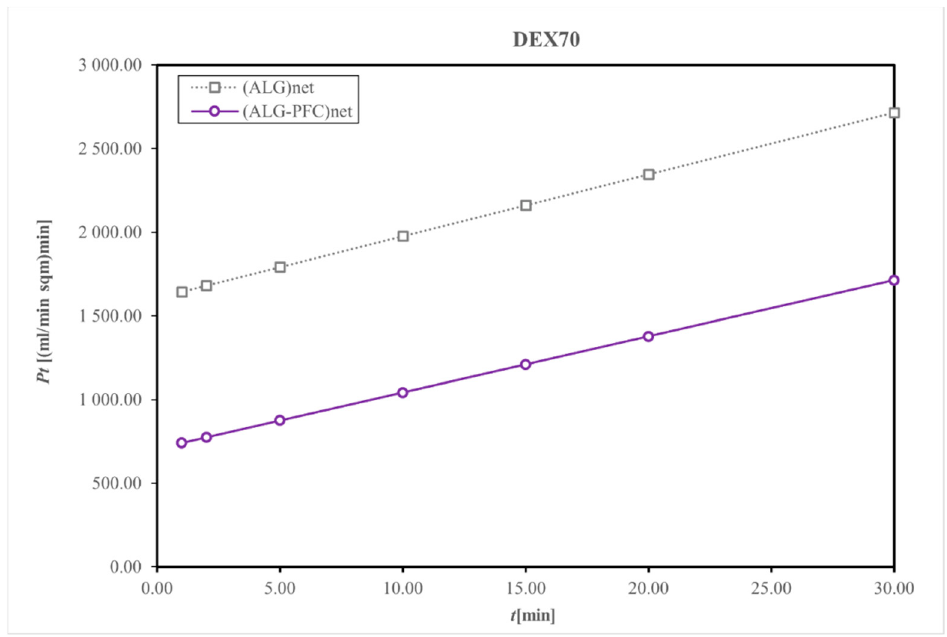
Figure 7. Representative membrane permeability and time product during particular time intervals permeation for Dextran 70. Key to symbols: (ALG-PFC) net —alginate–perfluorooctyl cross-linked; (ALG) net —alginate cross-linked. Moreover, the membranes do not delimit the transport of the albumin (70 kDa) and immunoglobulin levels (150